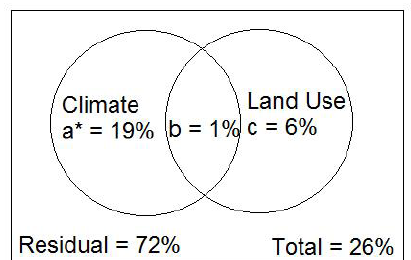
Figure 4. Diagram showing the importance of climate and land use to explain the limnological characteristics of floodplain lakes of the Araguaia River. The partial component: (a) purely climate, (b) shared between climate and land use, (c) purely land use, and (d) Residual. * Indicates significant P values <0.05. For this model the residual not showed spatial autocorrelation